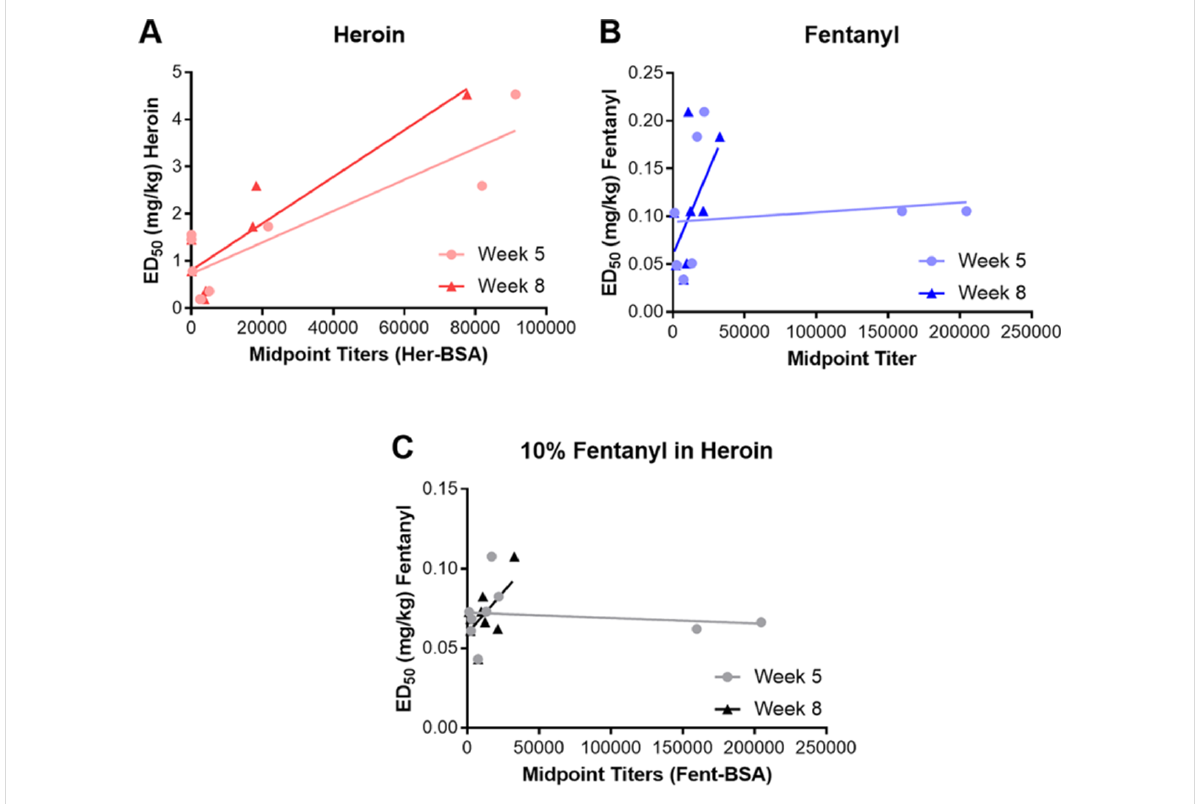
Figure 7: Correlation plots of dual hapten vaccines comparing week 5 and 8 ELISA midpoint titers to ED 50 values. Linear regression analysis was performed and R 2 values for week 8 are A) heroin week 8 R 2 = 0.7803; B) fentanyl week 8 R 2 = 0.3459; C) 10% fentanyl in heroin week 8 R 2 =